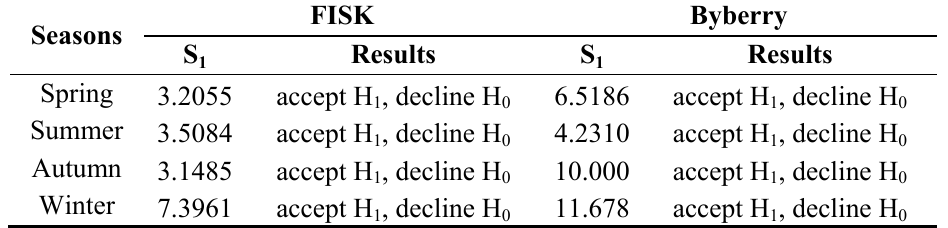
Table 15. Diebold and Mariano Test between the proposed hybrid PCA and ARIMA